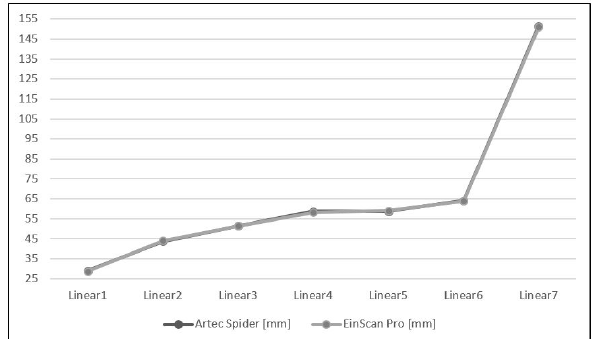
Table 7. DS analysis of the “Statuetta” model